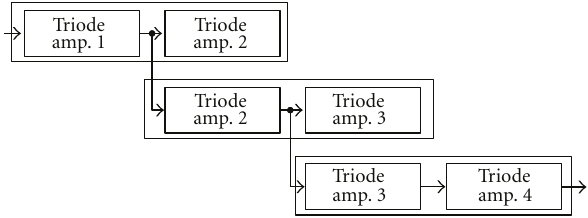
Figure 2: Preamp block decomposition using modified blockwise method [13].